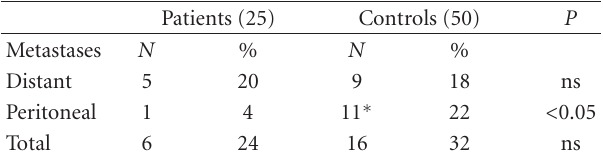
Table 4: Site of